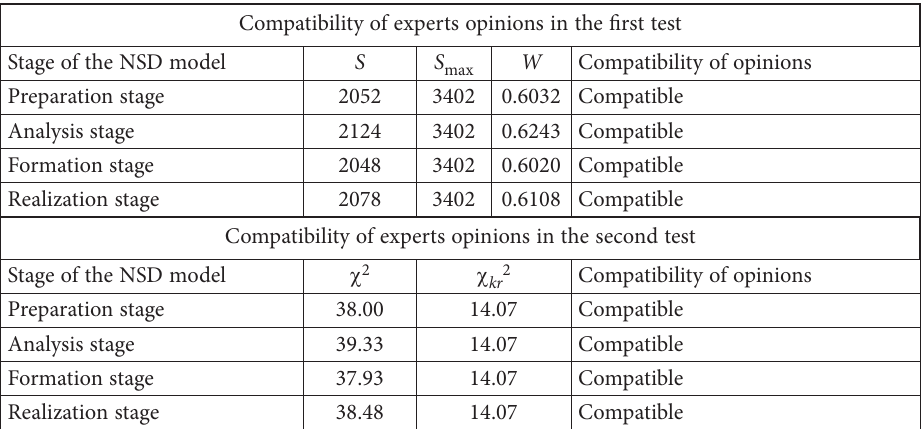
Table 4. Results of compatibility of Lithuanian experts’ opinions (source: compiled by the